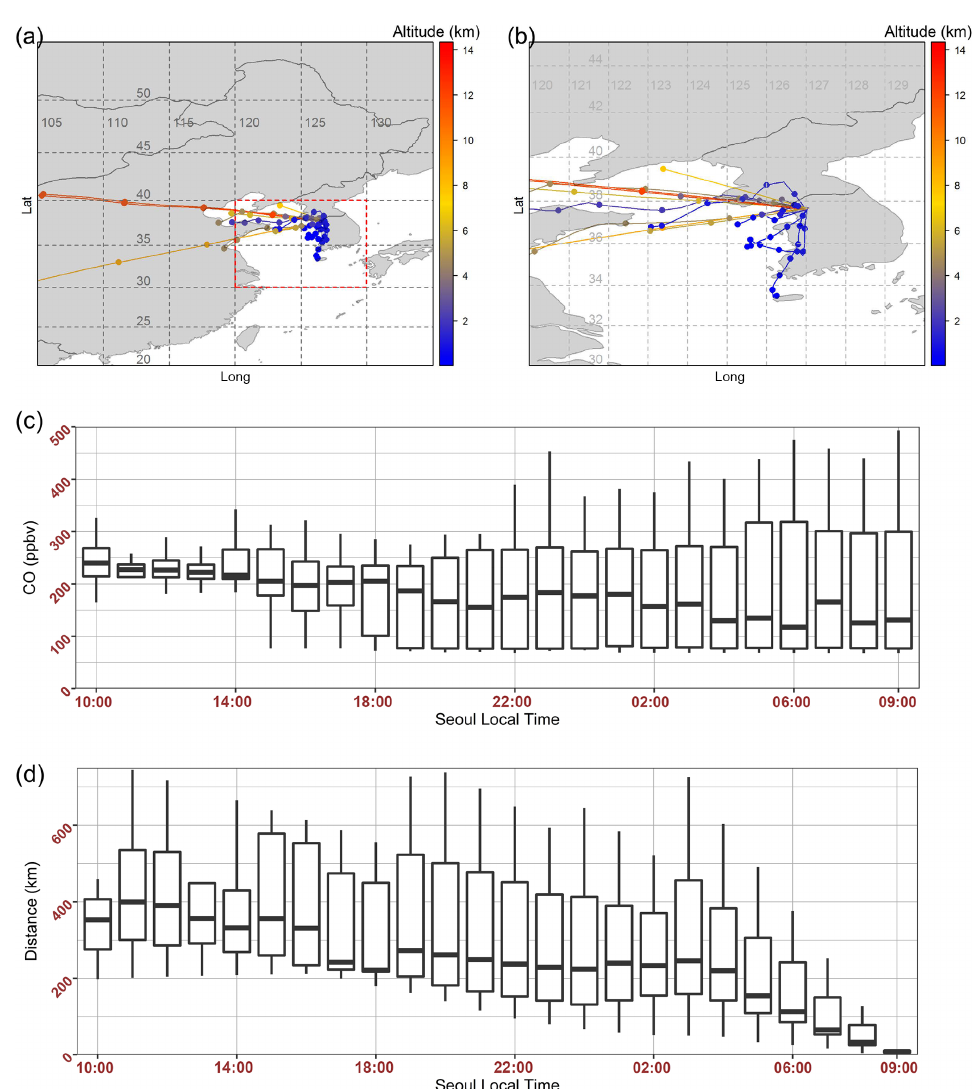
Figure 10. C-TRAIL output for the extreme pollution period (EPP) for Seoul as the receptor: (a) 24h trajectories of packets for the entire domain, (b) 24h trajectories of packets for the zoomed area in South Korea, (c) boxplots of the CO concentrations of all packets at each hour before they reached Seoul, and (d) boxplots of packet distances from Seoul at each hour before the packets reached